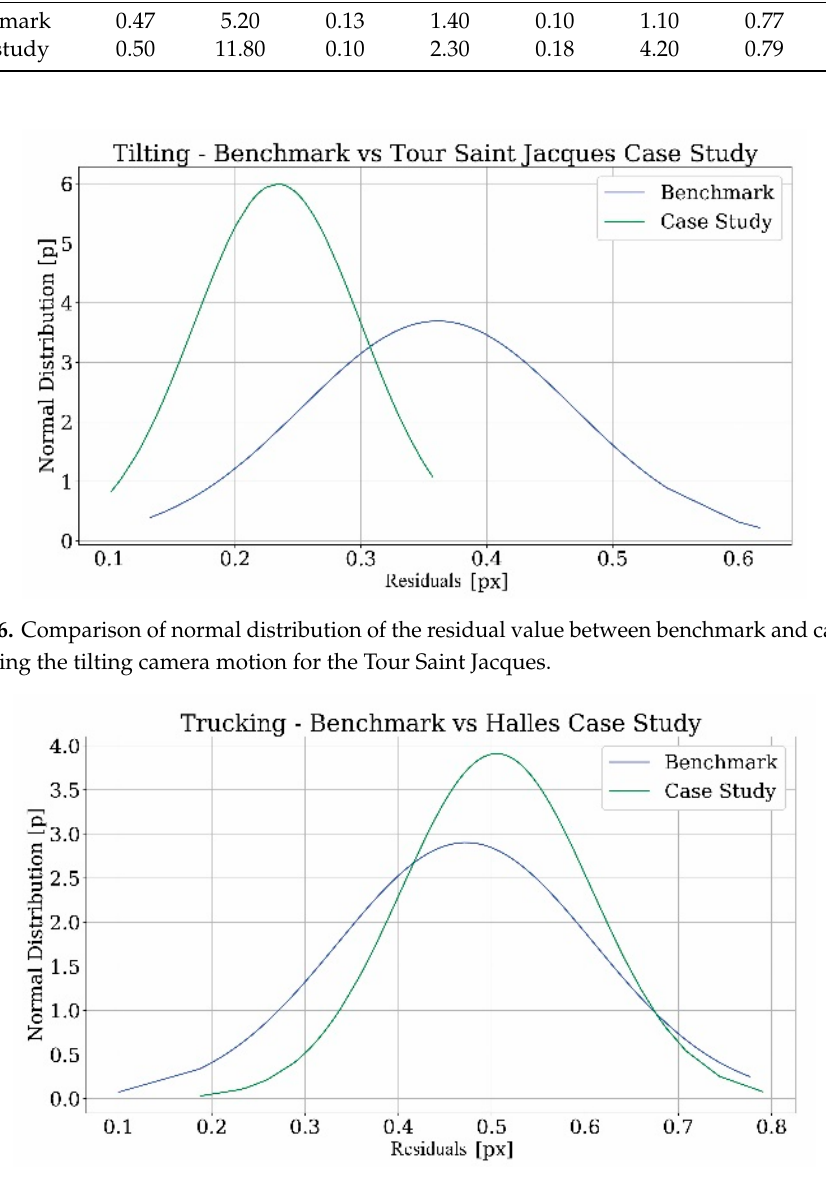
Figure 27. Comparison of normal distribution of the residual value between benchmark and case study considering the trucking camera motion for Les Halles.